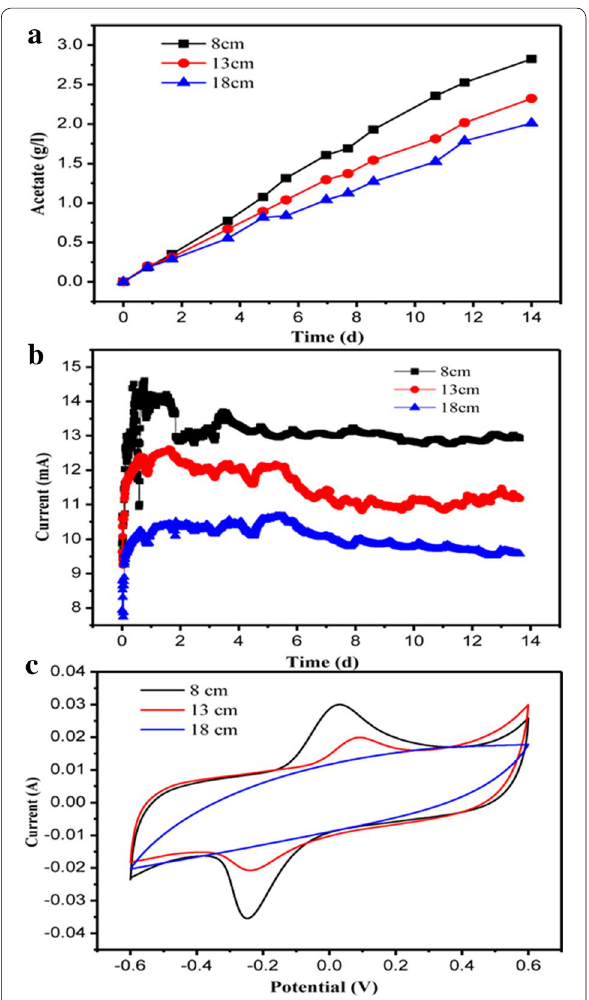
Fig. 2 Effect of electrode spacing on the MES performance in terms of a acetate production, b current, and c cyclic voltammetry